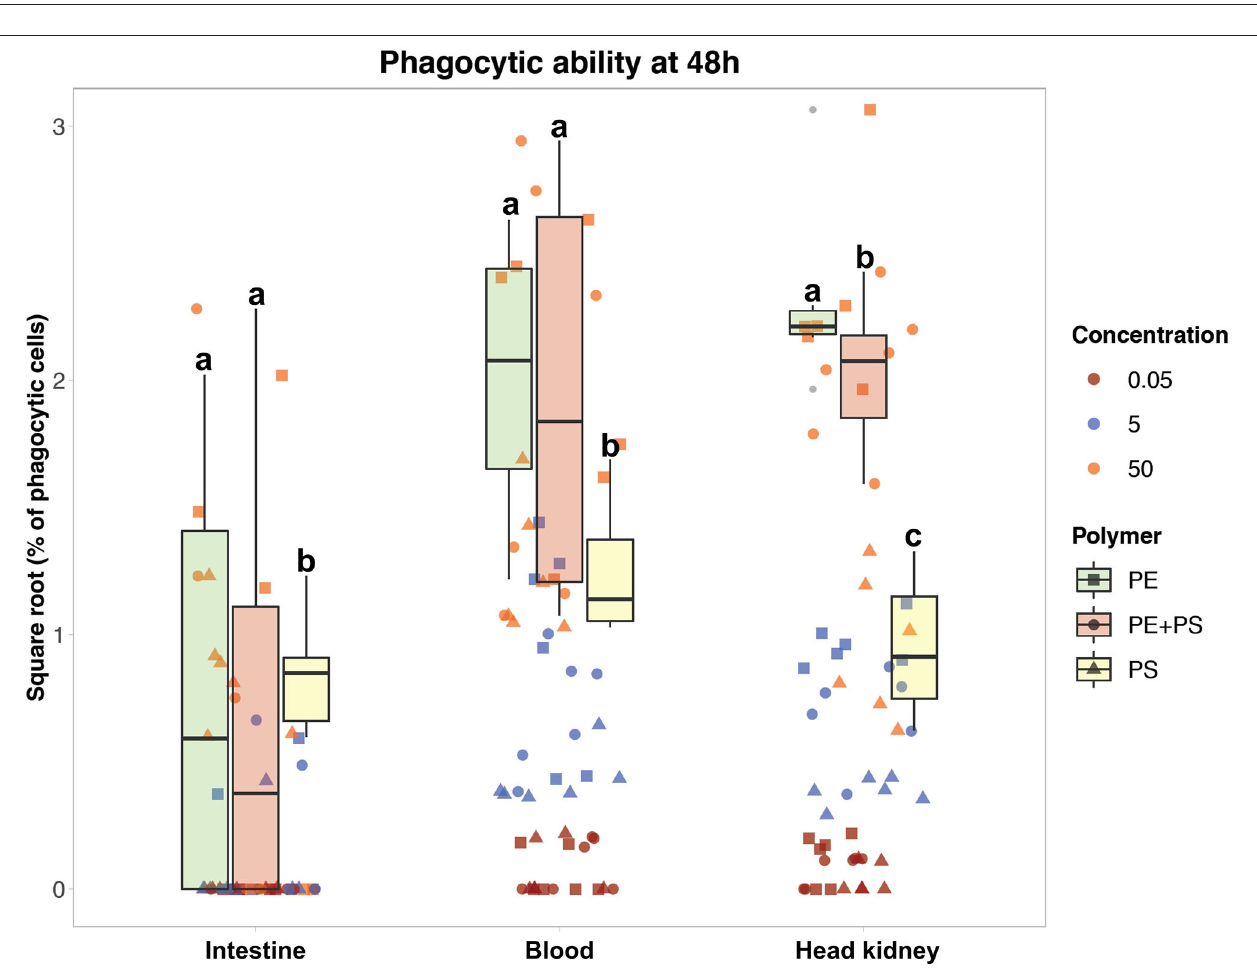
FIGURE 3 | Phagocytic ability of Atlantic salmon immune cells after 48h of exposure to MP. The color codes for the three MP concentrations are: maroon (0.05 mg/L), blue (5 mg/L), and orange (50 mg/L). The boxplots represent the phagocytic ability of the cells exposed to the high MP concentration (50 mg/L) of PE (green), PE + PS (red), and PS (yellow) at 48h. Different letters above the box plots represent statistical differences in the ability of the cells from the same tissue to phagocytose different polymers.